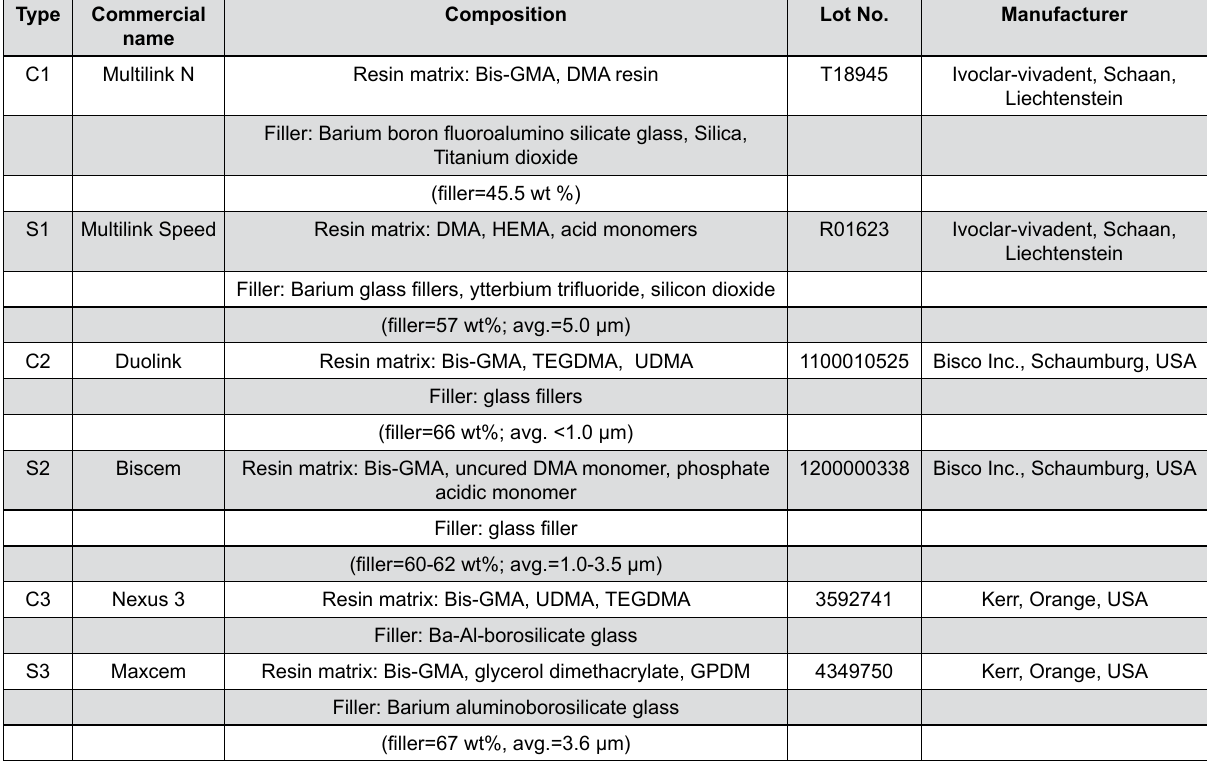
Bis-GMA: Bisphenol A-diglycidyl methacrylate; TEGDMA: triethylene glycol dimethacrylate; DMA: dimethacrylate; HEMA: 2-hydroxyethyl methacrylate; UDMA: urethane dimethacrylate; GPDM: Glycerophosphoric acid Figure 1- Components of the resin cements tested in this study